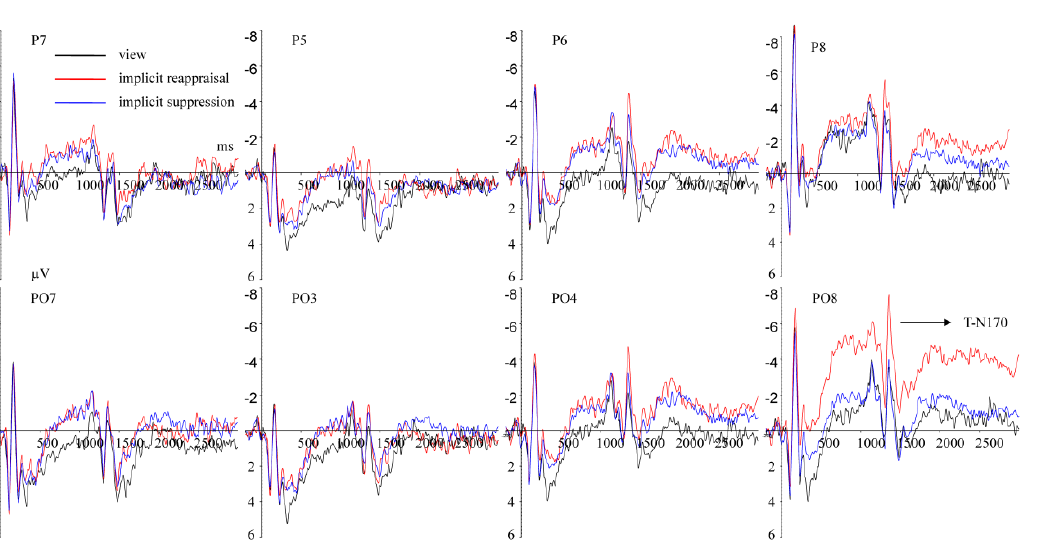
Figure 5. Grand average ERPs of T-N170 components for view (black lines), implicit reappraisal (red lines), and implicit suppression (blue lines), under implicit fear priming condition, recorded at P5, P6, P7, P8, PO3, PO4, PO7, and PO8.